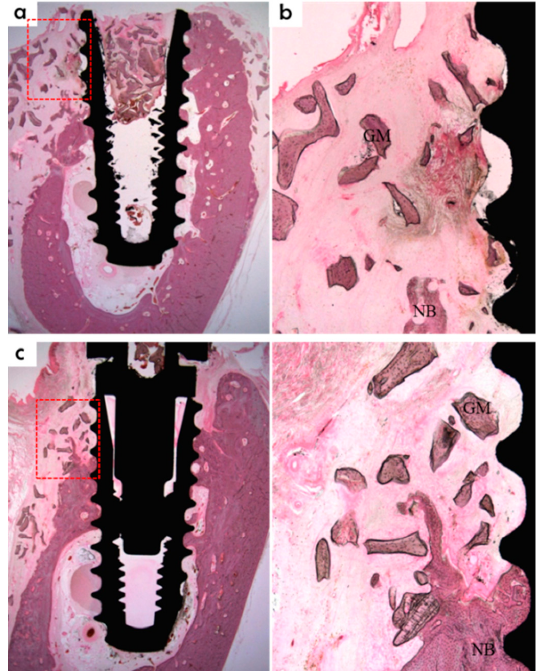
Figure 11. Histological sections of the control group at week 8 after operation. Little new bone was observed. GM, bone grafting material; NB, new bone. (H&E stain; original magnification 12.5× ( a ) and ( c ); 40× ( b ) and ( d )). Red box in ( a ) is the area of ( b ), red box in ( c ) is the area of ( d ).